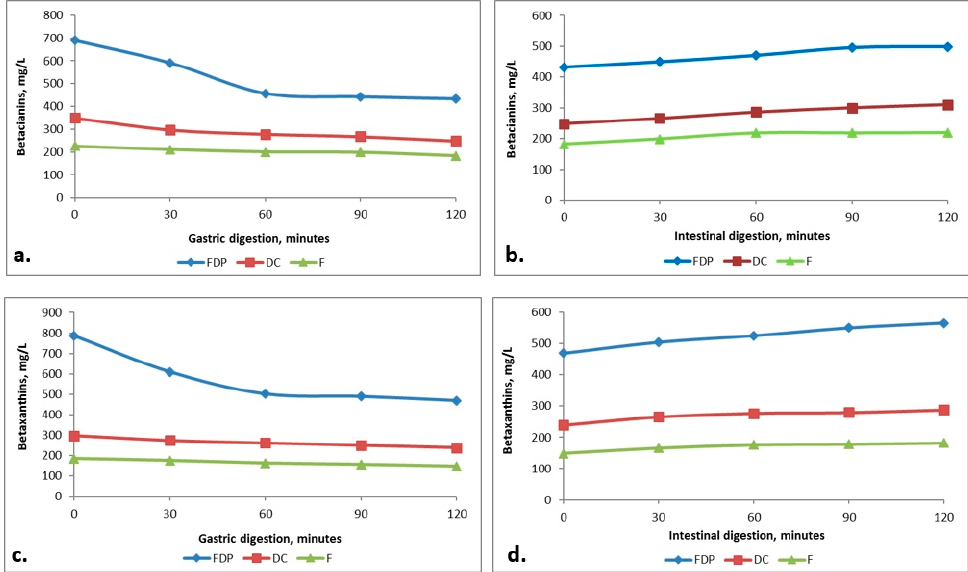
Figure 5. The digestibility of the beetroot products betacyanins (BC) and betaxanthins (BX) content during the gastric digestion ( a , c ) and the intestinal digestion ( b , d ).